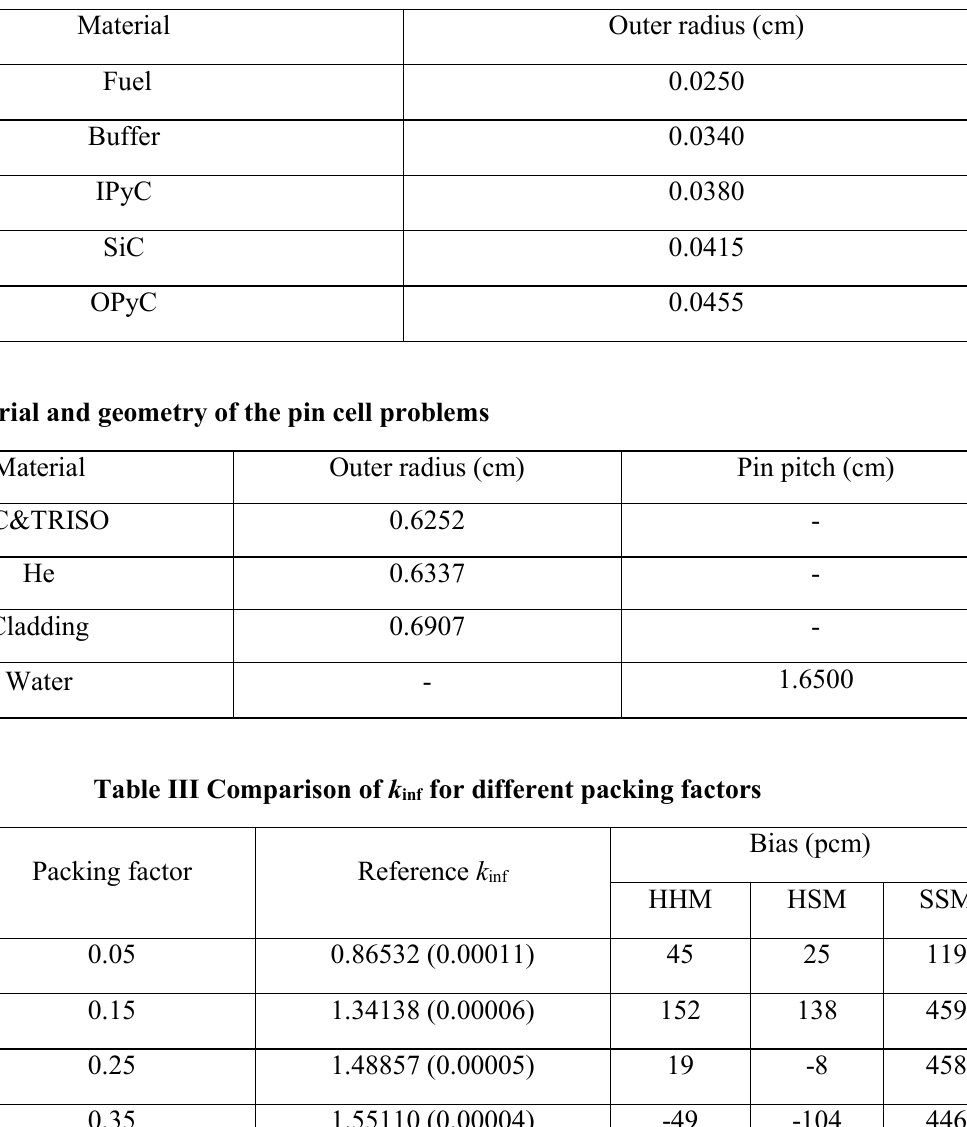
Table I Material and geometry of TRISO particle